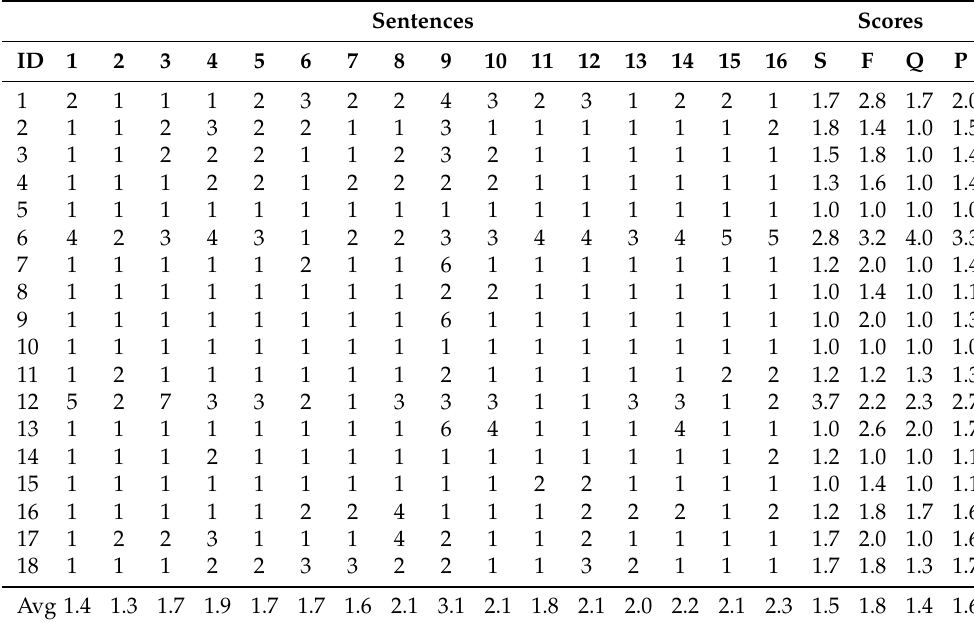
Table A5. PSSUQ results for the Ecuadorian volunteers.